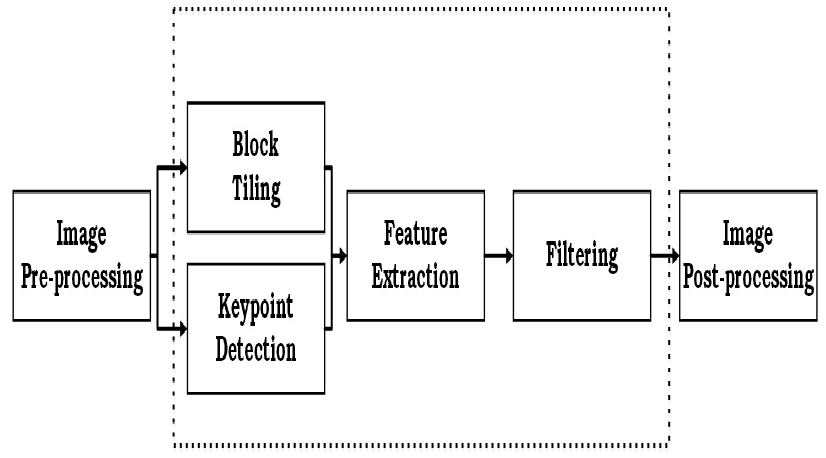
Figure 4. A generic framework to identify tampered images, adapted from